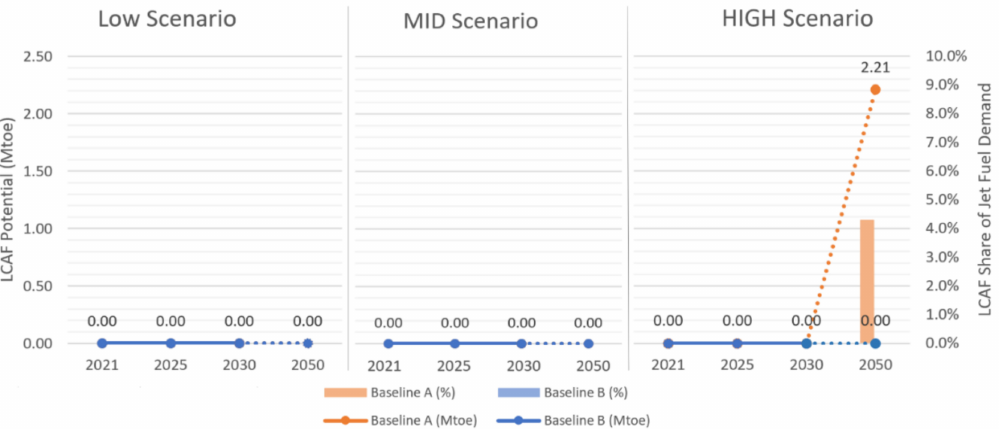
Figure 6. LCAF technical potential at EU-27 level and corresponding share of total energy demand for aviation. Calculated using output volume-based allocation